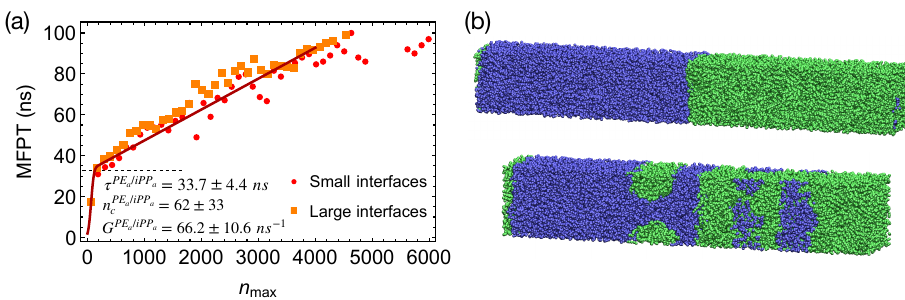
Figure 7. ( a ) MFPT for the largest crystalline nucleus to reach size n max in strongly segregated blends of PE a /iPP a oligomers. Fit to classical nucleation theory (red curve); ( b ) snapshots of PE a /iPP a with small interfaces ( upper ) and large interfaces ( lower ) before crystallization. PE a (green) and iPP a